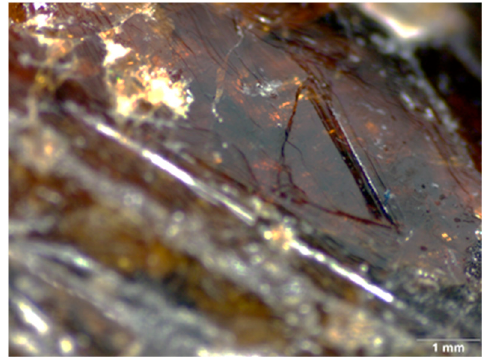
Figure 3. Triangular etching of MG-5.